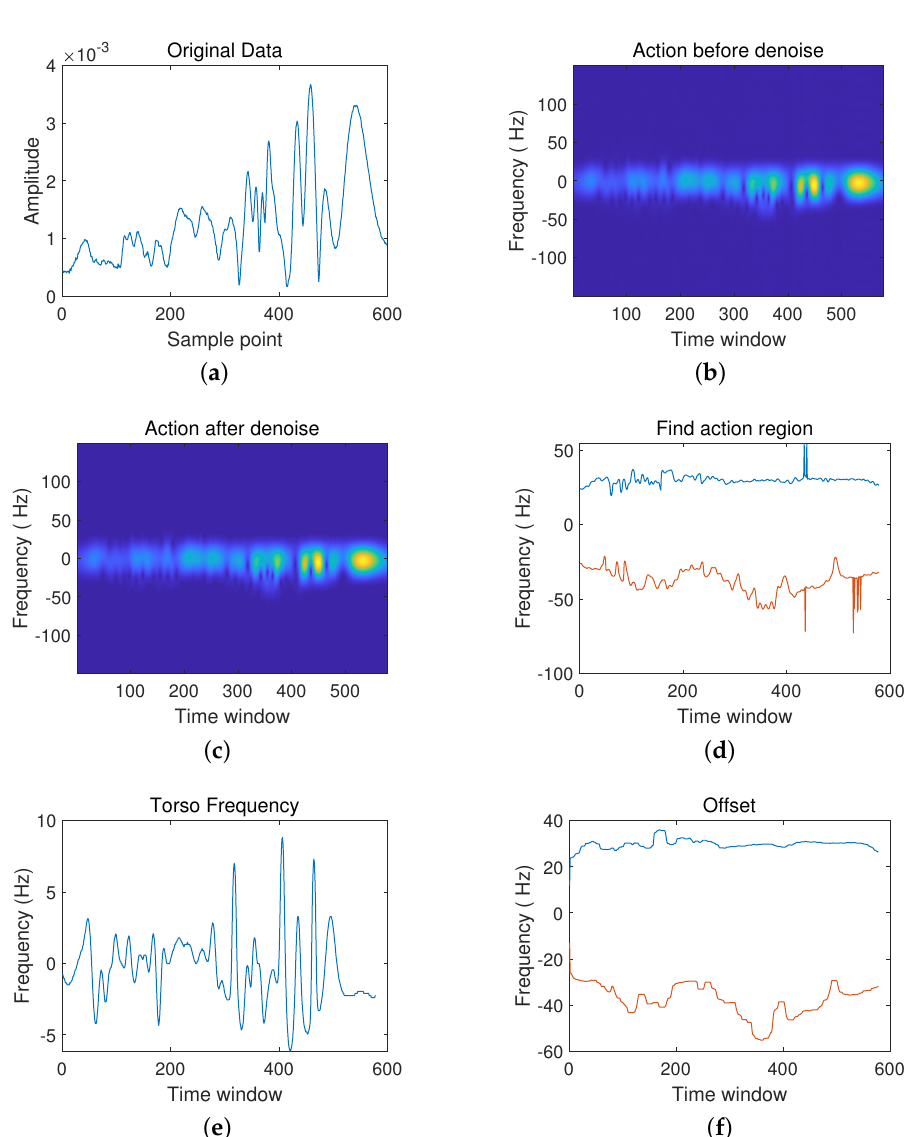
Figure 8. Schematic Diagram. ( a ) The original data; ( b ) Frequency Spectrum Diagram Before Noise Reduction; ( c ) Frequency spectrum diagram after noise reduction; ( d ) Action interval; ( e ) Body frequency; ( f )